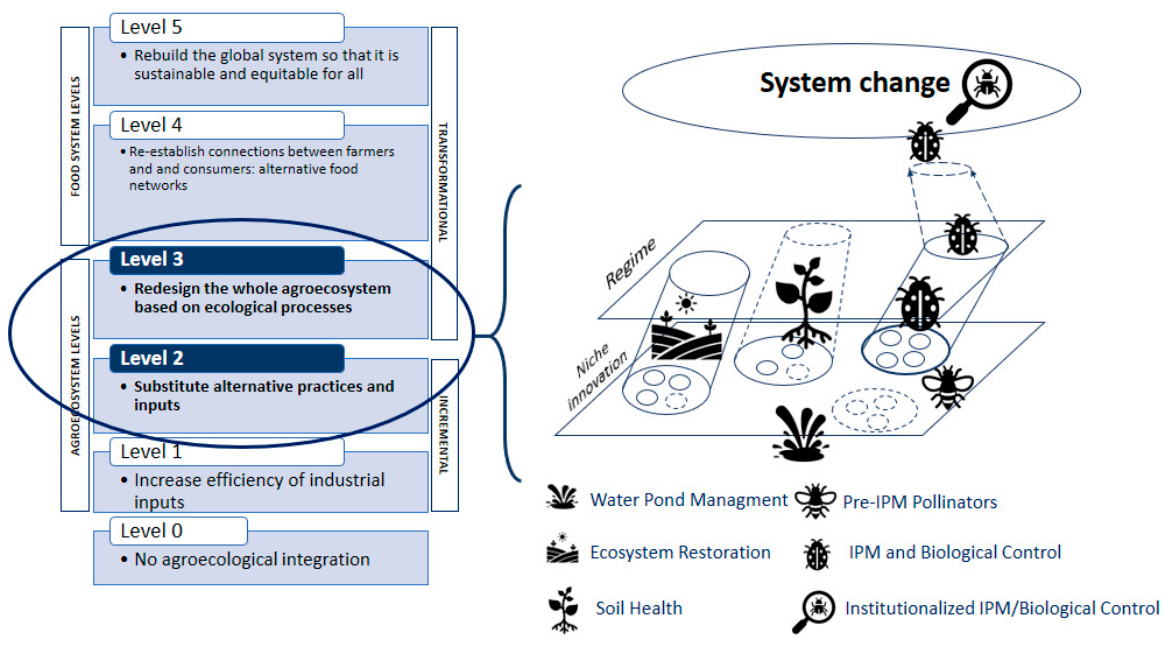
Figure 1. Focus of article and Almeria’s location in the five levels of agroecology and four niche experiments in the multi-level perspective; authors’ elaboration based on Gliessman, S. [53], Geels, F.W. [36], and Pereira, L.M., et al. [58].